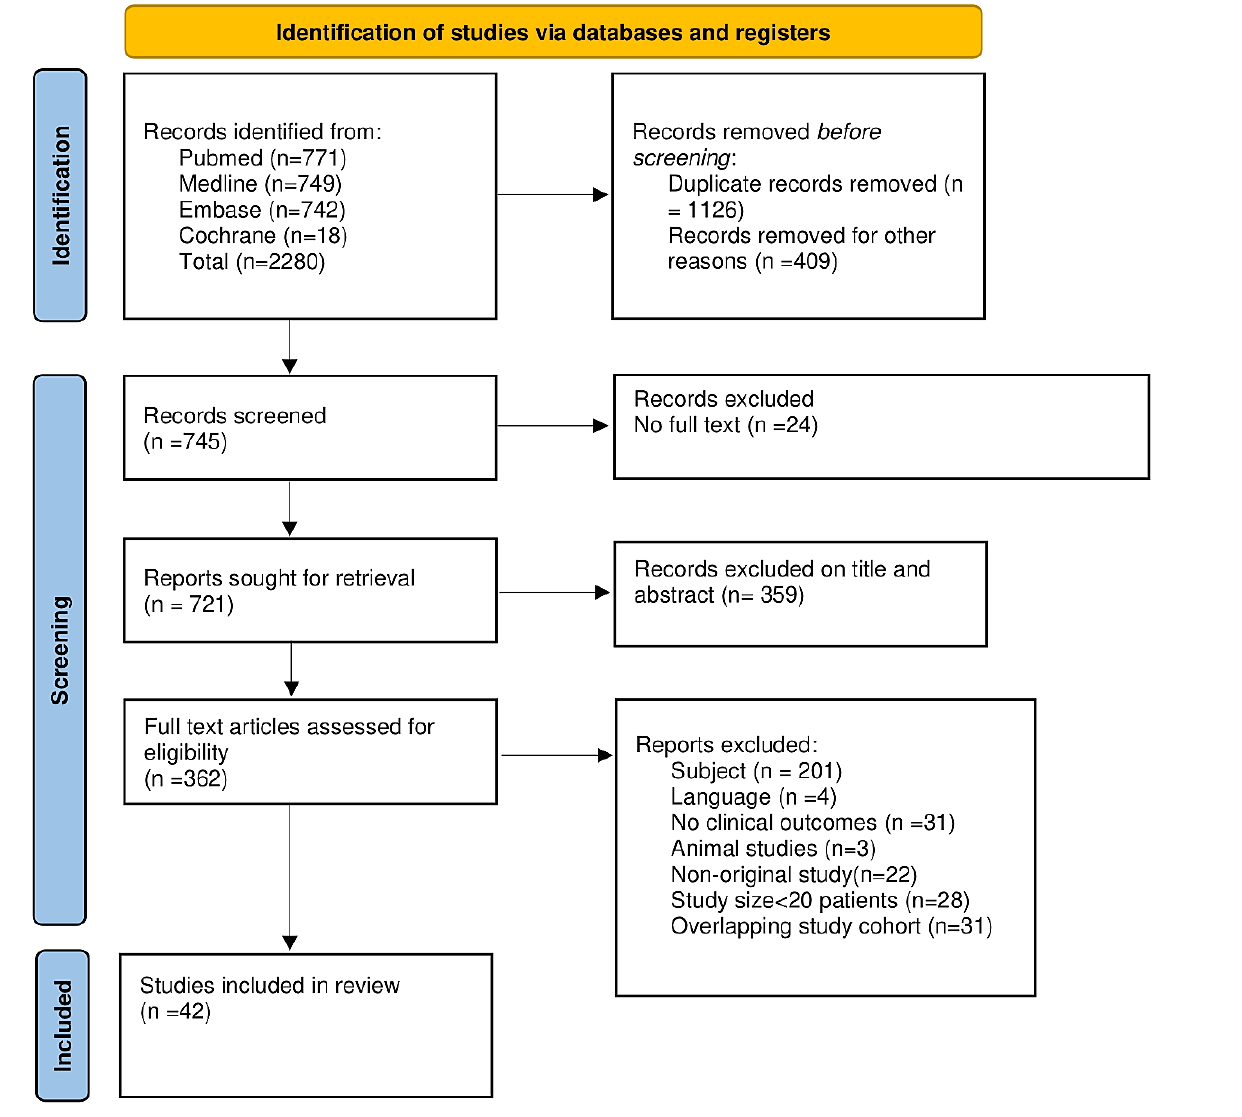
Figure 3. Prisma flow diagram.